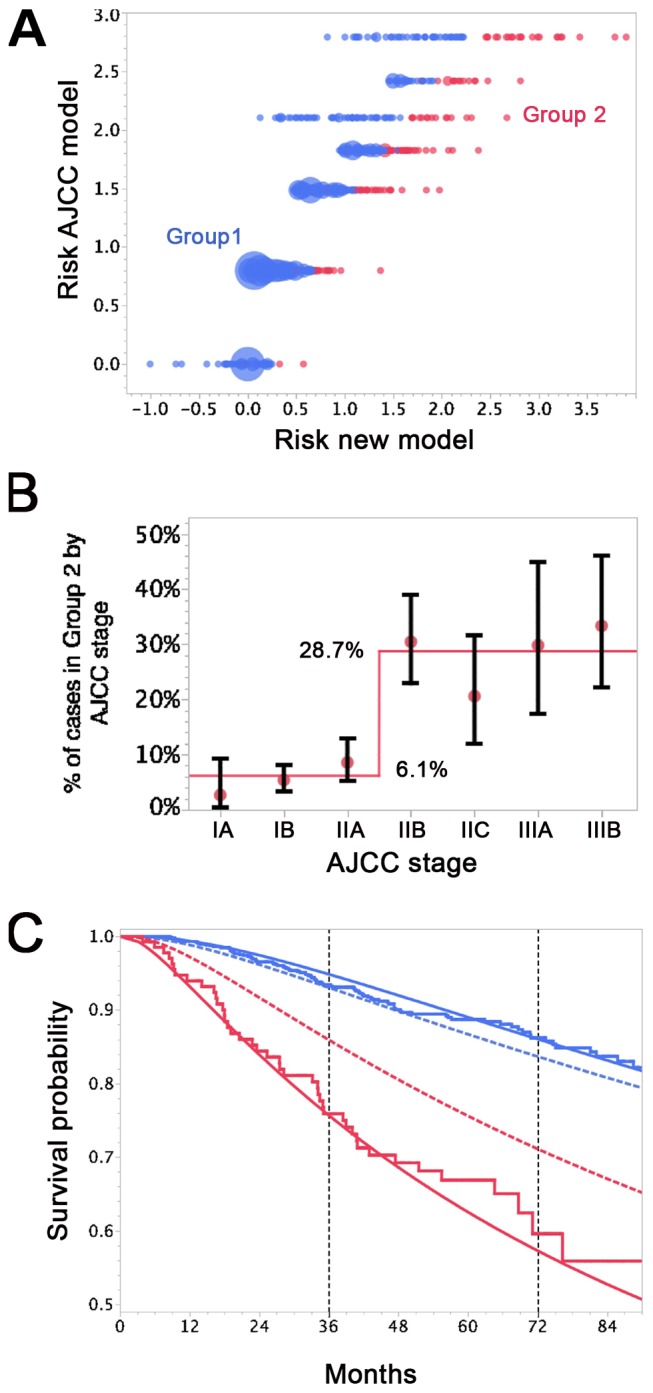
Differences in survival prediction between this study's model and the AJCC-based model.(A) Joint distribution of the individual risk scores for the 1,027 patients according to two predictive survival models: (1) “Risk new model” refers to the lognormal model with the predictors tumor thickness, DCCD, and ulceration; (2) “Risk AJCC model” refers to a lognormal model based on the seven categories of the AJCC classification (stage IA, IB, IIA, IIB, etc.). The risk scores are sums of products of the individual predictors multiplied with the corresponding regression coefficients. (Since some tumor thicknesses are less than 1 mm we obtain also negative risk scores because tumor thickness enters on a log scale.) The area of the bubbles is proportional to the number of patients with identical combinations of risk values. The largest bubble contains 30 patients. The smallest bubbles represent one patient each. In Group 2 (red; n = 136) the survival probability for a patient from the new model is at all times smaller than the survival probability according to the AJCC model. The remaining patients form Group 1 (blue; n = 891). Note that there are only seven risk groups for the AJCC model, while the new model exploits the full risk range. (B) Observed (red filled circles; together with the exact 95% confidence intervals) and fitted percentages of patients in Group 2. Almost 29% of patients with AJCC stage > IIA are in Group 2, whereas only about 6% of patients with AJCC stage < IIB are in Group 2. (C) Observed (Kaplan-Meier survival estimates; step functions) and predicted survival probabilities for the new model (continuous lines) and the AJCC model (dashed lines) for the Group 1 (blue) and Group 2 (red). Note the large difference between the AJCC model and the new model for Group 2 and the perfect fit of the observed survival and the new model's predictions for Group 1 after 60 mo.